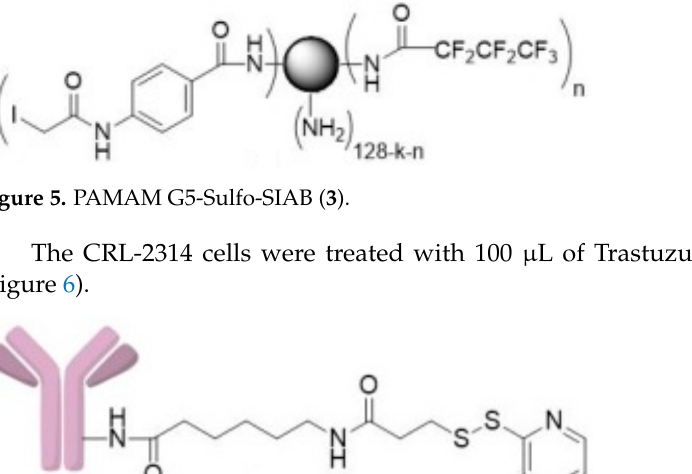
Figure 4. Fluorinated PAMAM G5.